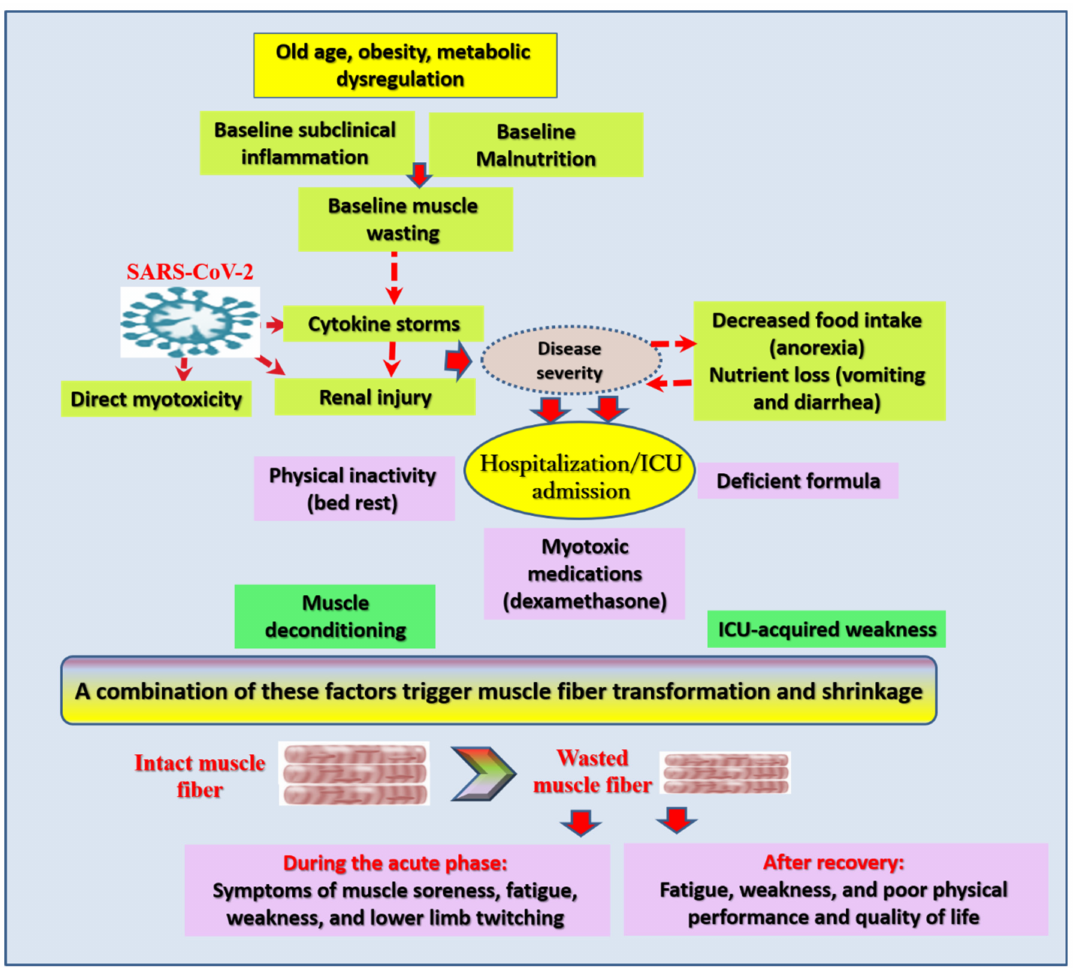
Figure 1. Possible factors contributing to skeletal muscle injury in Coronavirus disease 2019 (COVID-19) patients. Abbrevia- tions: SARS-CoV-2: severe acute respiratory syndrome-coronavirus-2, ICU: intensive care unit. Catabolic molecules released in individuals with baseline sarcopenia and obesity usually occurring in older adults and comorbid conditions, secondary to inflammaging and malnutrition, along with the cytokine storms induced by SARS-CoV-2, may directly injure muscular structures. Energy imbalance associated with gastrointestinal symptoms, muscle deconditioning by prolonged bed rest, myotoxic drugs such as dexamethasone, deficient nutrition, the cytokine storm, and mechanical ventilation contribute to ICU-acquired weakness among critical COVID-19